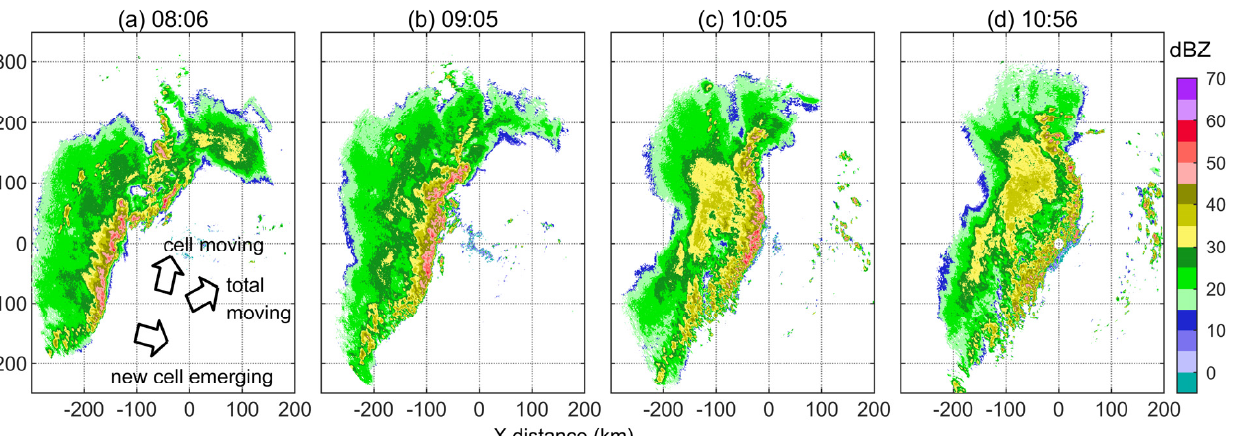
9 of 19 Figure 2. Example of extrapolation results in ideal experiments based on simple images: ( a ) only translation, ( b ) add increment, and ( c ) direction change. Samples are two ‐ dimensional normal dis ‐ tribution images with an initial value range of 0~1, and contour lines for 0.5 are shown. The transla ‐ tion speed in ( a ) and ( b ) is 0.5 grids per time in both the X and Y directions. A 0.01 increment over time is added in ( b ). The rotation speed of the extreme center in ( c ) is 3 degrees per time. The his ‐ torical samples shown are t = 1~10, the predictions start from t = 10, and the object is at t = 20. NGT is modeled using all ten historical samples, while OF uses only t = 9~10. The X and Y axes are dis ‐ tances with arbitrary units. 3.3. Real Case 1: A Convective Line with Shape Evolution A convective weather event with obvious movement and shape change in radar echo images is selected first. A squall line event occurred in the U.S. on 20 May 2011, which